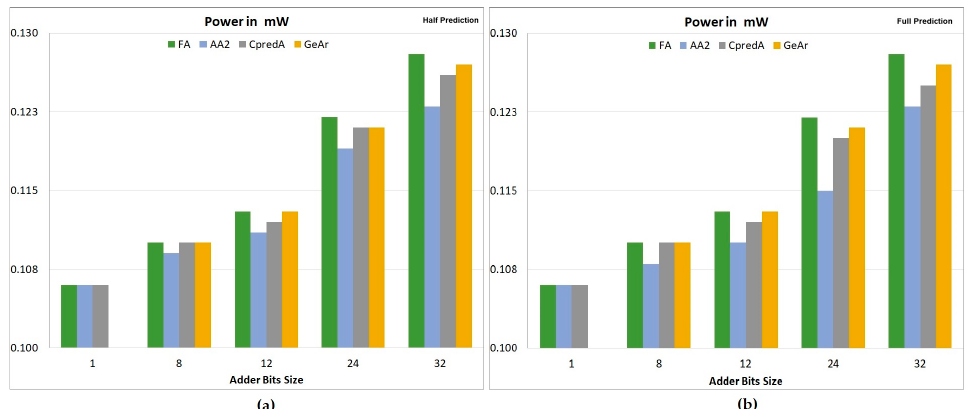
Figure 11. Power estimation of adders in ( a ) half prediction, ( b ) full prediction configurations.